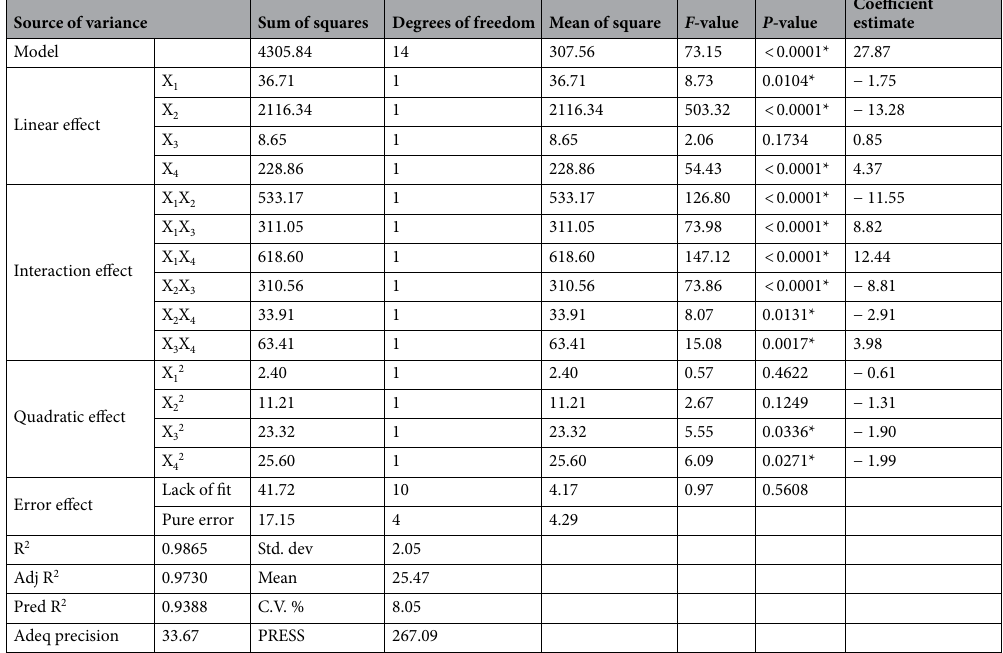
Table 2. Analysis of variance for biosorption of methyl orange dye by using Fucus vesiculosus. F Fishers’s function, P level of significance, C.V. coefficient of variation. * Significant values.